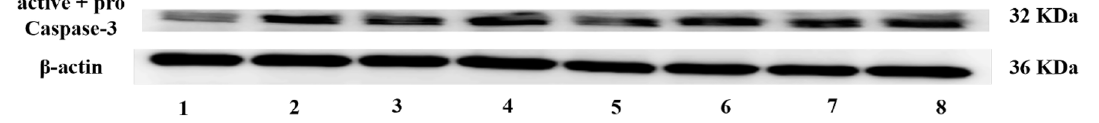
Figure 12. Effects of different treatments on the p-Caspase expression in IPEC-J2. After being treated for 24 h, the expression of p-Caspase expression was determined using the western blot. β-actin served as an internal marker. The different treatments were: 1. Control treatment (T1); 2. SBA treatment (T9); 3. KRT8- siRNA treatment (T2); 4. KRT8-siRNA + SBA treatment (T10); 5. KRT18-siRNA treatment (T3); 6. KRT18-